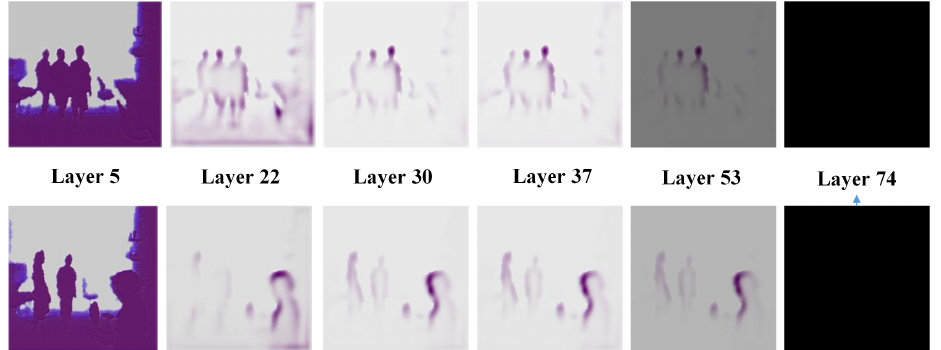
Figure 2. Convolutional feature visualization. The top and bottom rows depict the feature visual- ization results for the 5th, 22nd, 30th, 37th, 53rd, and 74th layers of the Darknet-53 network for two different depth image